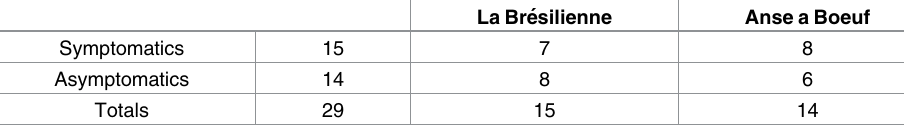
Table 1. Demographics of the participants from Sud-Est,